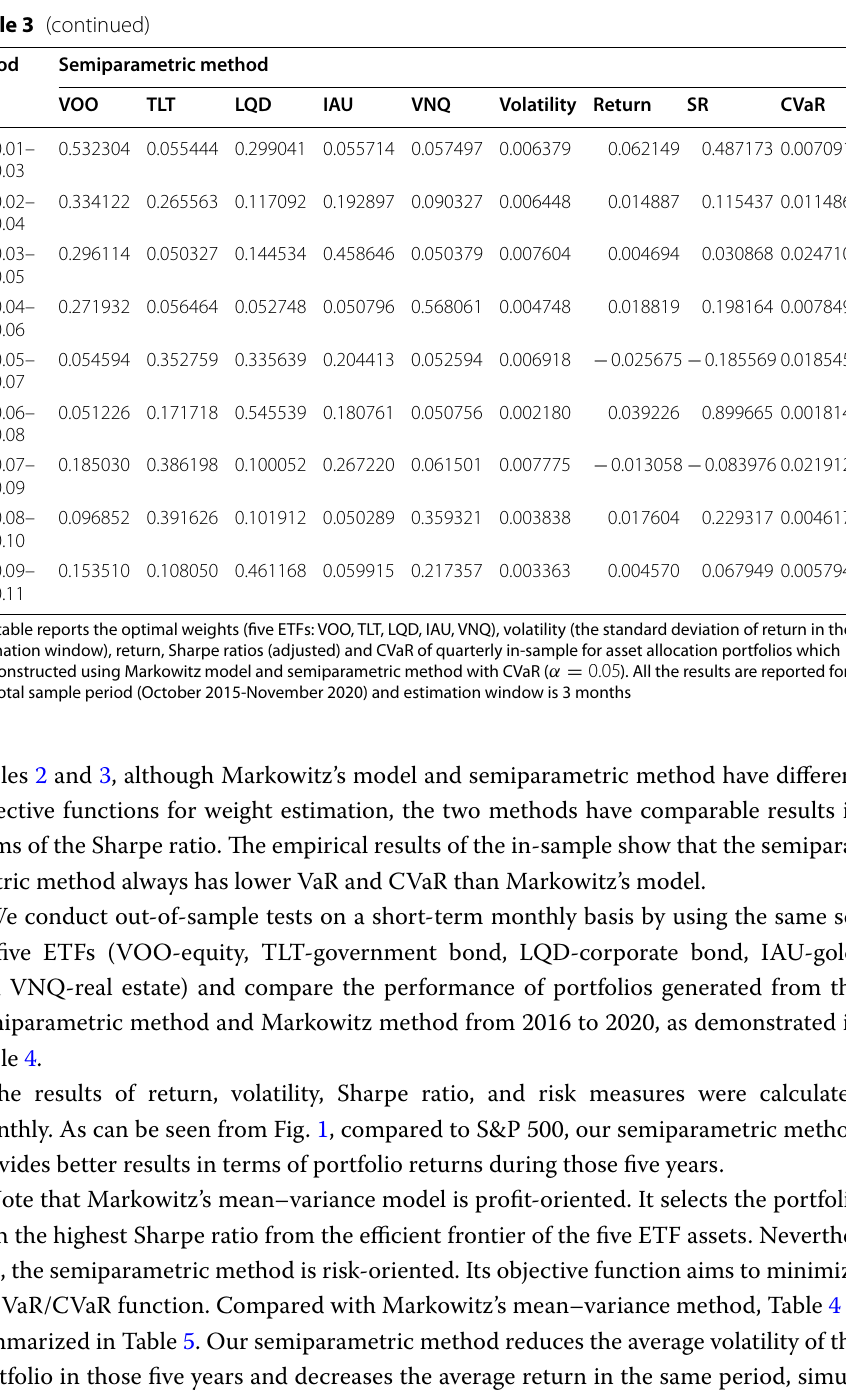
0.05 ). All the results are reported for =